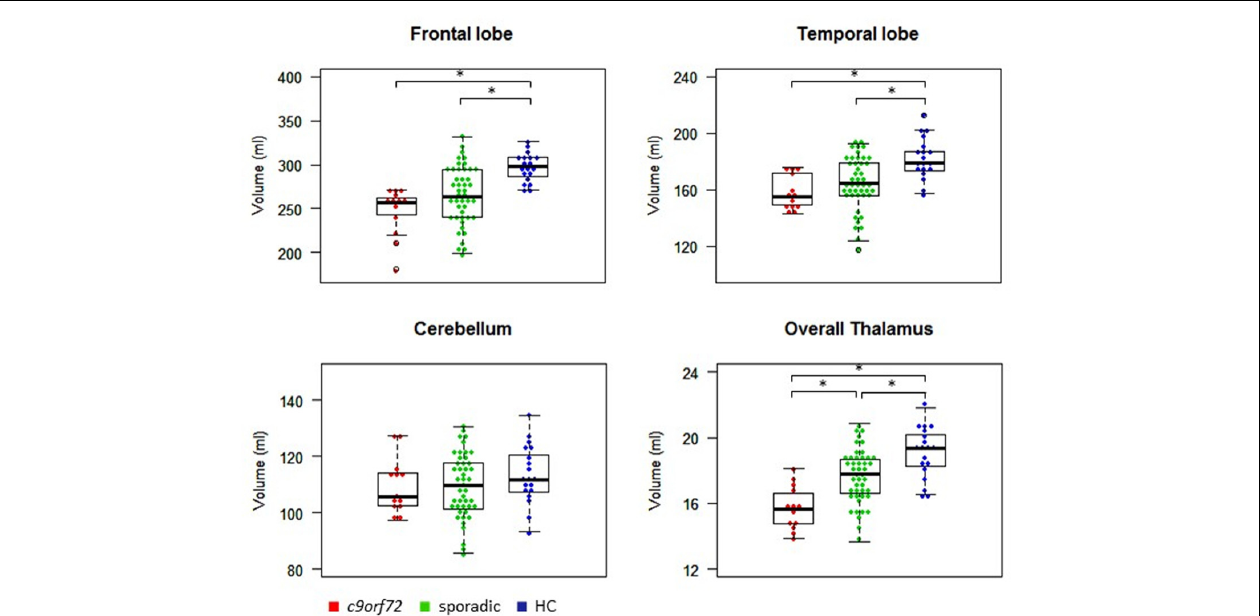
FIGURE 1 | Volumes of frontal and temporal lobe, cerebellum and thalamus. ∗ Indicates significant